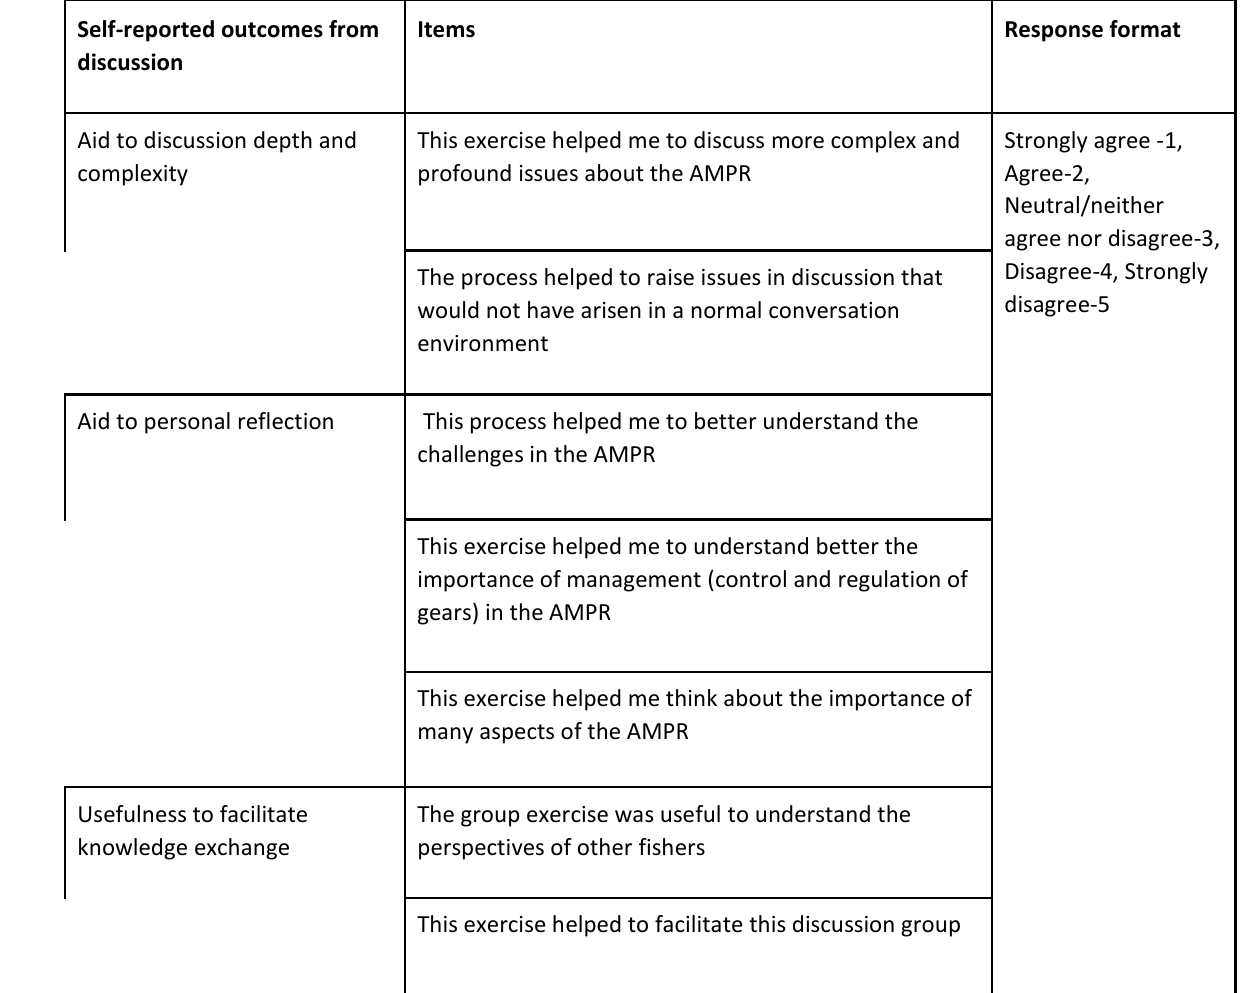
Table A3.1 Outcomes, items and response format used for the self-assessment questions given to participants post